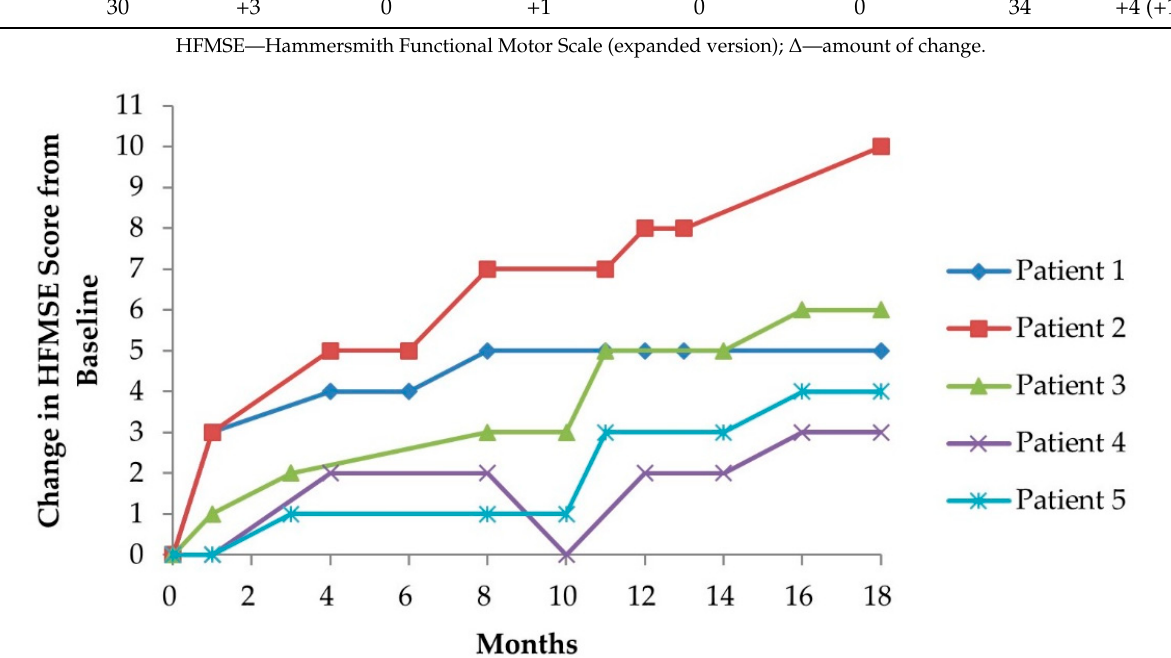
Table 3. Change in Purdue Pegboard scores from baseline.